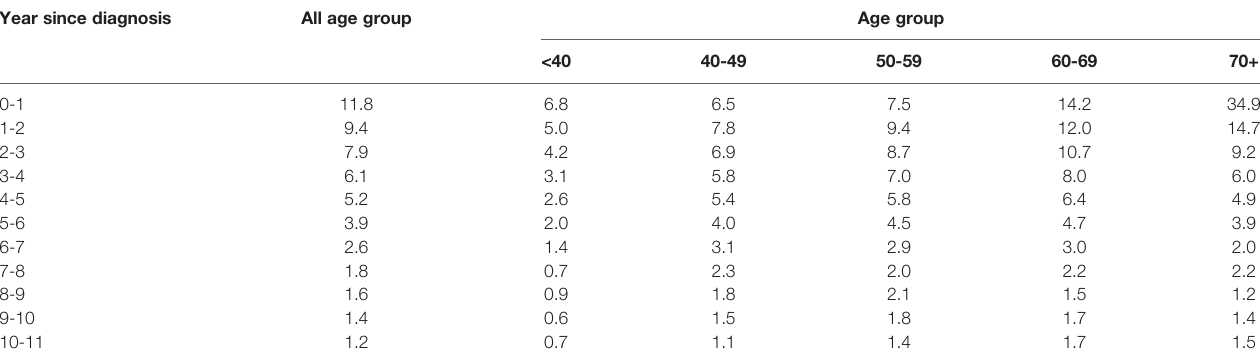
TABLE 3 | Conditional probability of death by age group and year since